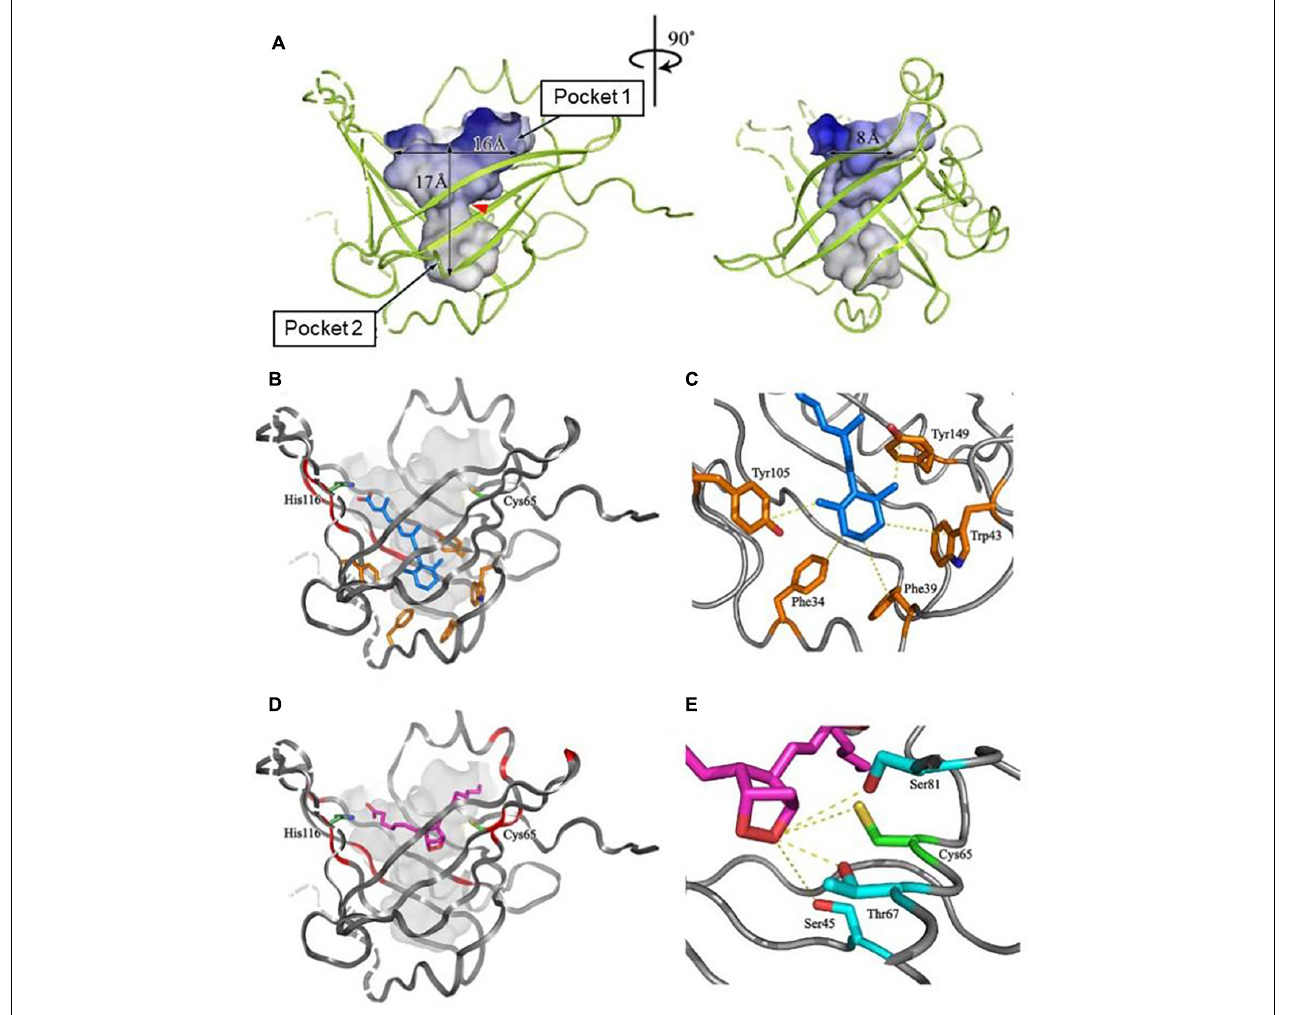
FIGURE 3 | The structure of a large central cavity of L-PGDS (A) and docking models of the complexes with all-trans -retinoic acid (B,C) or PGH 2 (D,E) determined by NMR (Shimamoto et al., 2007). The molecule of all-trans -retinoic acid are shown in light blue (B,C) . The carbon chain of PGH 2 is shown in purple and a 9,11-endoperoxide group, in orange (D,E) . Amino acid residues important for the ligand binding and the catalytic activity are shown in panels (C,E) ,